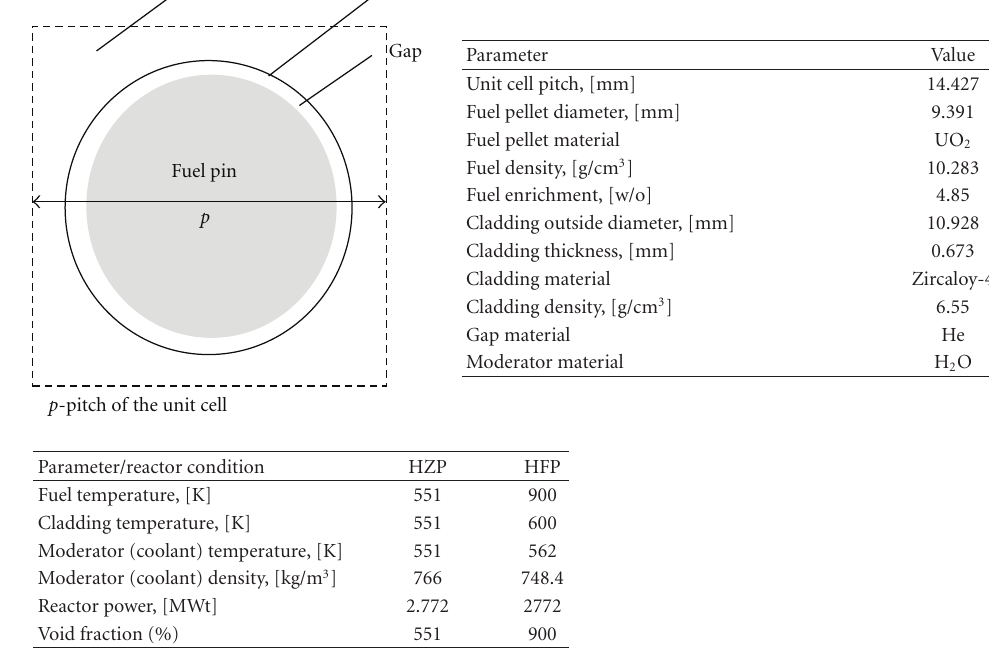
Figure 2: Configuration of TMI-1 PWR unit